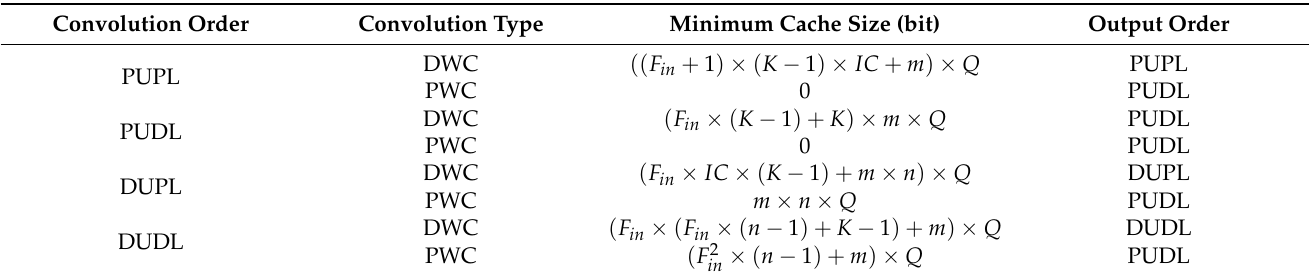
Table 1. The minimum preconvolution feature cache size and output order for DWC and PWC with various convolution